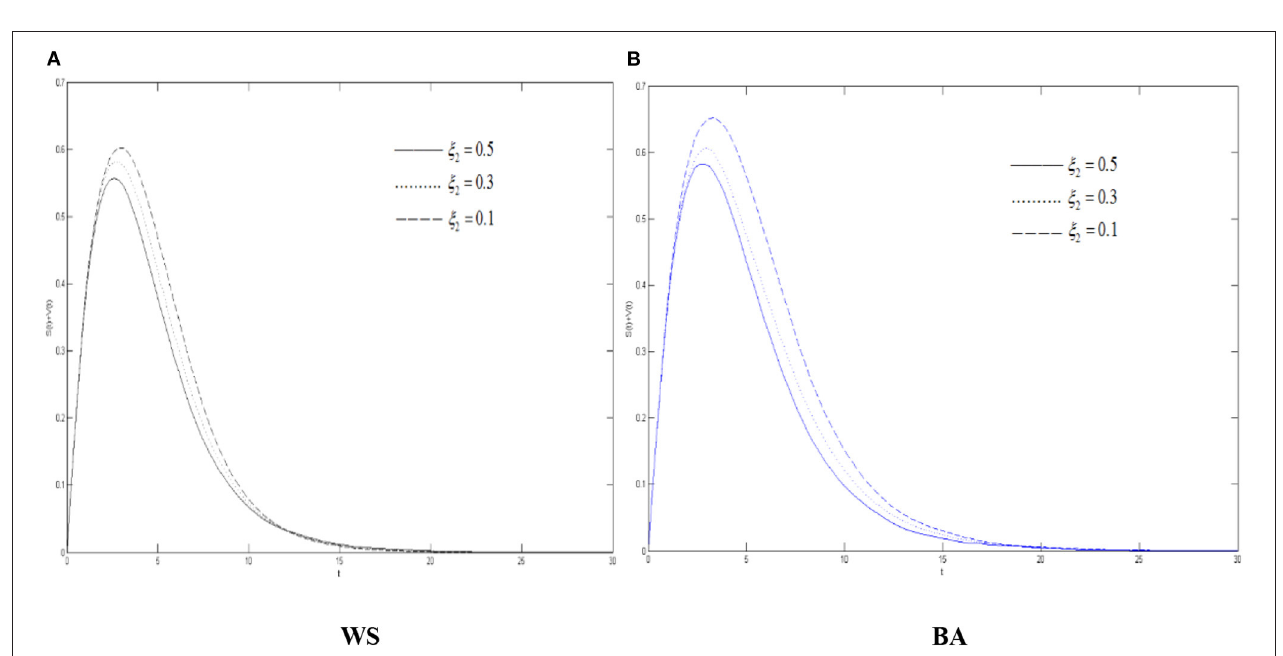
FIGURE 8 | The differences of the diffuser density in WS small world and BA scale-free network when ξ 2 changes. (A) WS, (B)